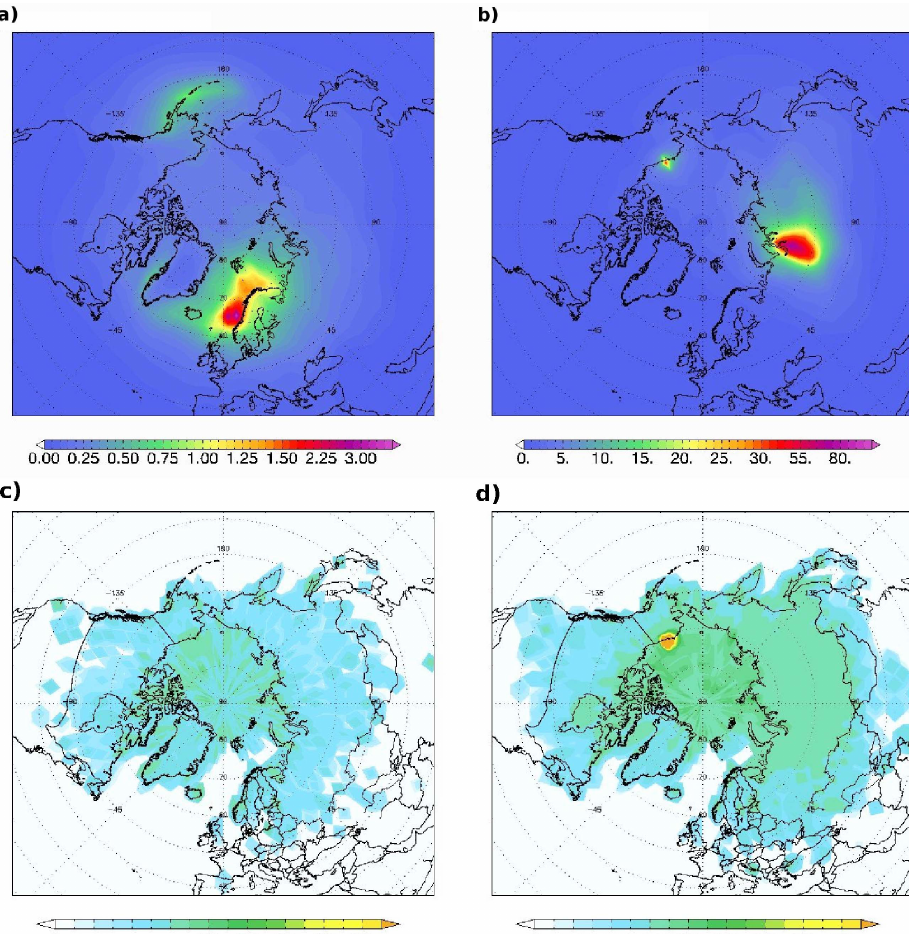
Fig. 5. BC effects from Arctic shipping and petroleum emissions. (a) Contribution to tropospheric column of black carbon [µgm − 2 ] from Arctic shipping activity in 2004. (b) Contribution to tropospheric column of black carbon [µgm − 2 ] from Arctic petroleum activity in 2004. (c) Radiative Forcing from black carbon on snow [mWm − 2 ] from Arctic shipping activity in 2004. (d) Radiative Forcing from black carbon on snow [mWm − 2 ] from Arctic petroleum activity in